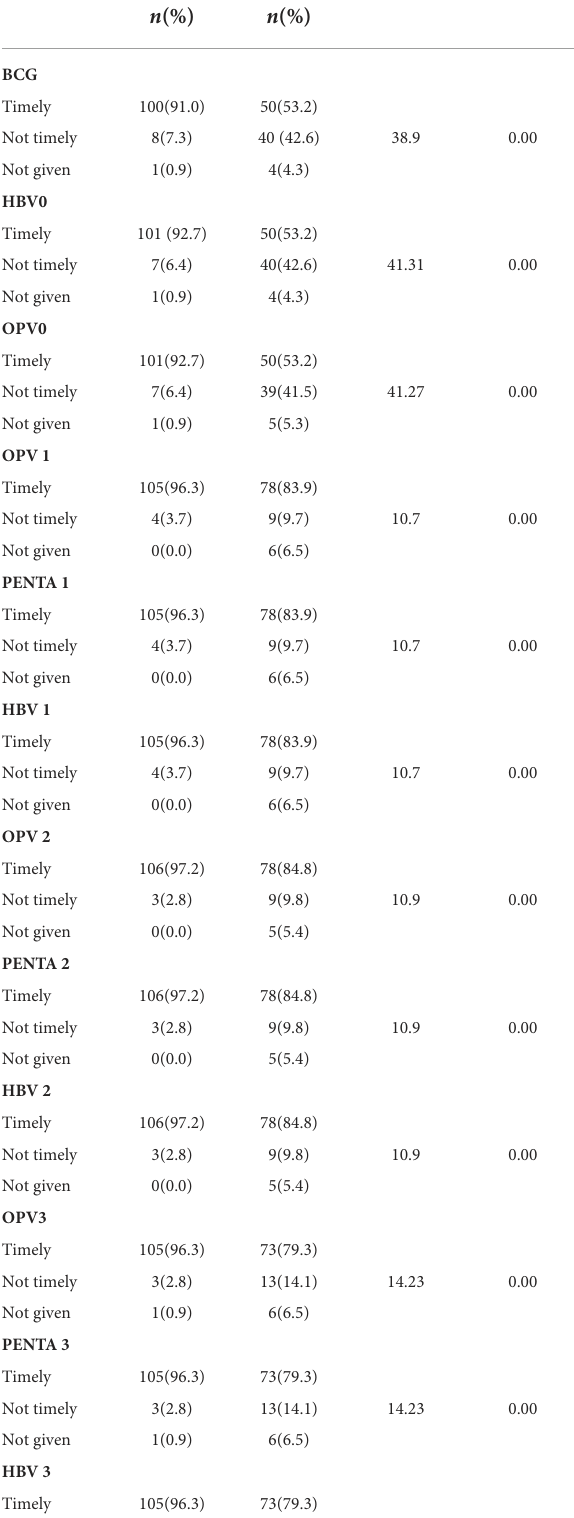
TABLE 3 Timeliness of vaccines among intervention and control group of infants from selected slum communities in Ibadan, Nigeria.